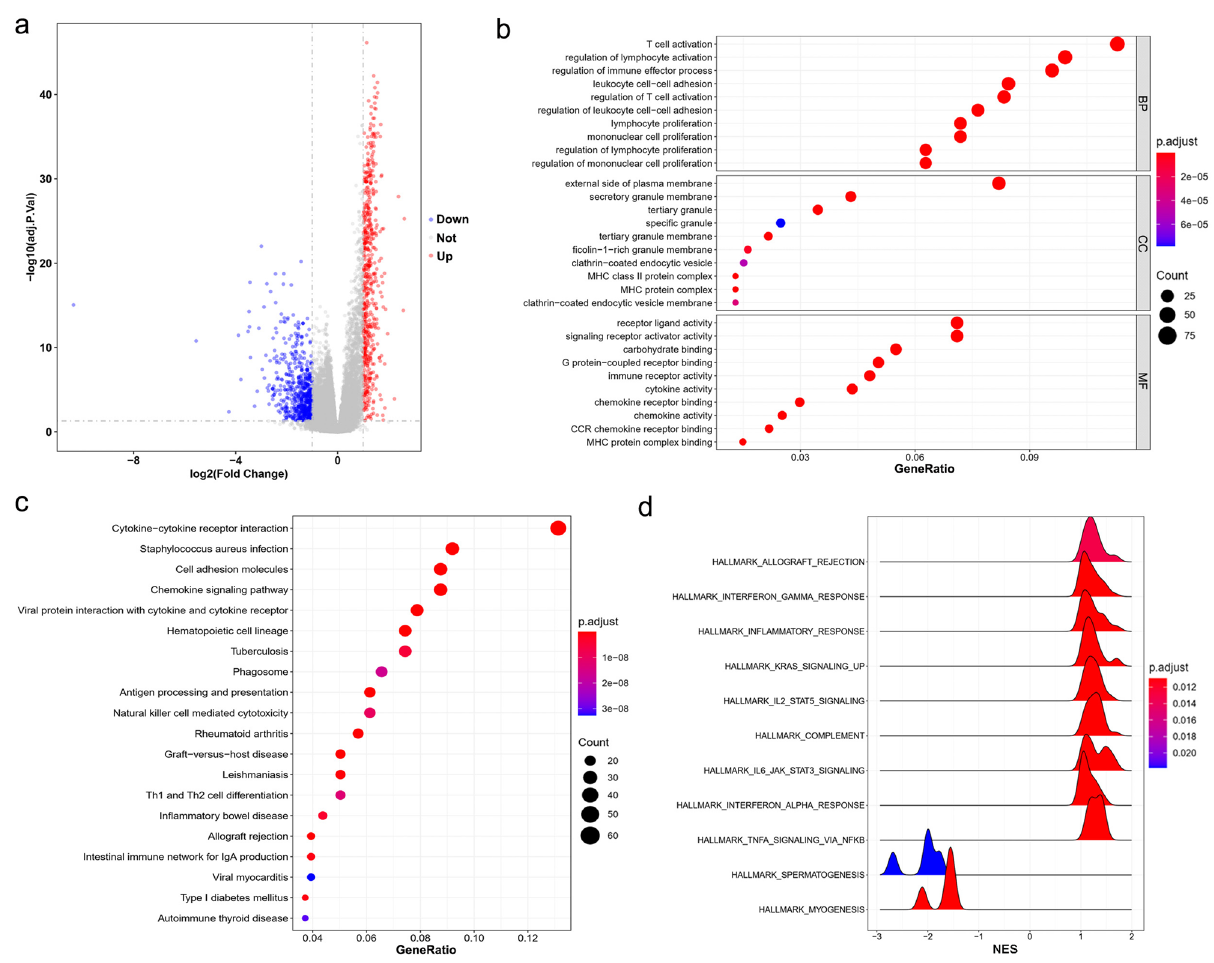
Figure 3. Enrichment analyses of differentially expressed genes (DEGs) between hot and cold tumors. ( a ) Volcano plot of the DEGs in the hot and cold tumors. Red plots (UP) represent significantly upregulated DEGs. Blue plots (Down) represent significantly downregulated DEGs. Grey plots (Not) represent DEGs with no significant difference. The vertical dashed line represents |log2FC|> 1 (fold change > 2) and the horizontal dashed line represents p.adjust value = 0.05. P.adjust value < 0.05 is considered significant. ( b ) Gene Ontology enrichment analysis of the top 10 enrichments for biological process, cellular component and molecular function. Enrichment levels are showed as a continuous variable from blue to red color. The bluer color represents the higher p.adjust value, and the redder color represents the lower p.adjust value. Enrichment counts are showed by dot sizes. The bigger size represents the higher enrichment count and the smaller size represents the lower enrichment count. ( c ) Kyoto Encyclopedia of Genes and Genomes analysis 24–26 . ( d ) Gene Set Enrichment Analysis is showed by normalized enrichment scores (NES) on X-axis and enriched pathways on Y-axis. The NES < 0 represents pathways enriched in cold tumors while the NES > 0 represents pathways enriched in hot